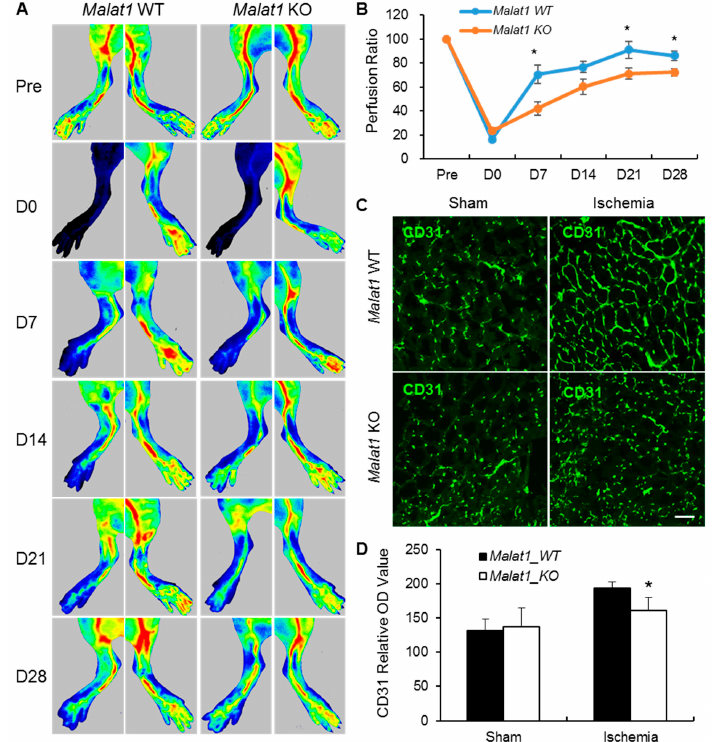
Figure 1. Effects of Malat1 genetic deficiency on local blood flow recovery after mouse hindlimb ischemia. ( A , B ) Malat1 knockout ( Malat1 KO) and littermate control ( Malat1 WT) mice were subjected to right femoral artery ligation and subsequently monitored by Laser Speckle imaging at days 0, 7, 14, 21, and 28 after hindlimb ischemia. The laser speckle pattern is visualized as a color-coded blood flow velocity with low flow = blue ; high flow = red . Representative images are shown in panel ( A ) and quantification of blood flow recovery is shown in panel ( B ) ( n = 8 per group). ( C ) Representative immunofluorescent images showing CD31-positive capillaries in transverse sections of non-ischemic (Sham-operated) and ischemic hindlimb gastrocnemius muscles from Malat1 WT and KO mice ( n = 5). Green color indicates CD31-positive staining; and ( D ) Quantitative analysis of CD31-positive capillaries in panel ( C ). In comparison with Malat1 WT controls, genetic deficiency of Malat1 significantly delays blood flow recovery and reduces vascular density in hindlimbs following ischemic insults. Data are expressed as mean ± SEM. * p < 0.05 vs. Malat1 WT + ischemia group. Scale bar represents 50 µm.